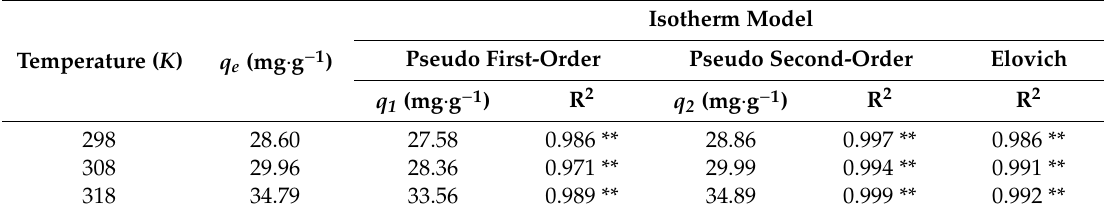
Table 2. Parameters of kinetic models for U(VI) adsorption onto HA.